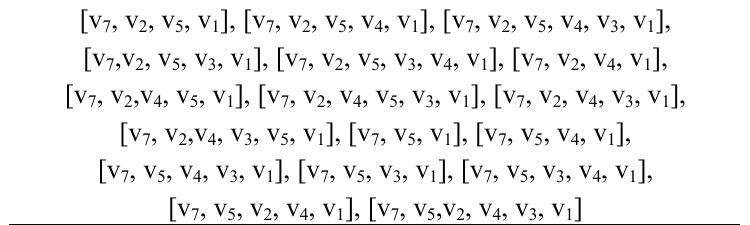
for flow (cid:1858) (cid:2874),(cid:2869)(cid:2869) from node (cid:1874) (cid:3033) (cid:3123),(cid:3117)(cid:3117)